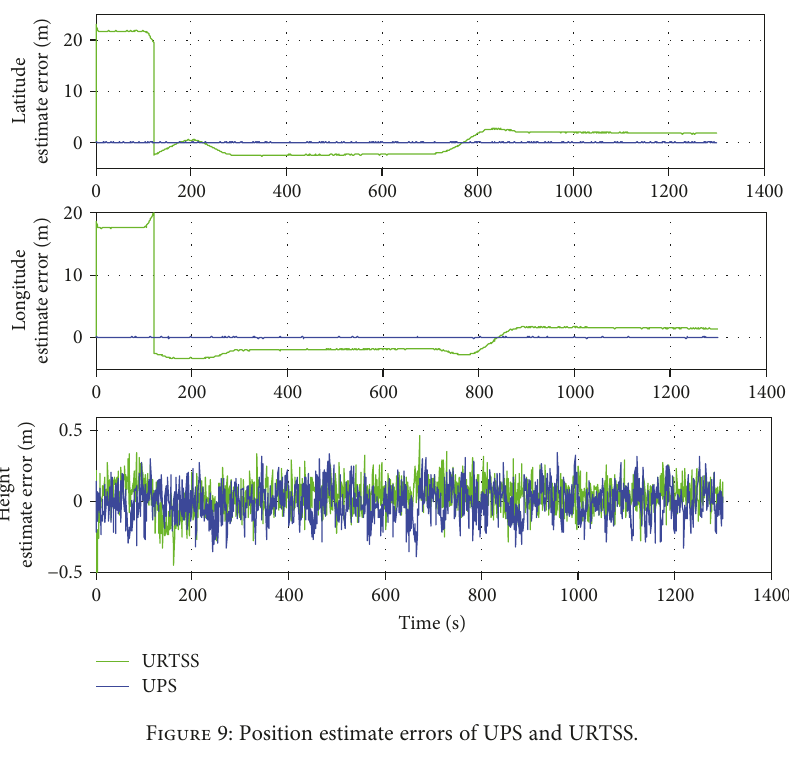
Figure 9: Position estimate errors of UPS and